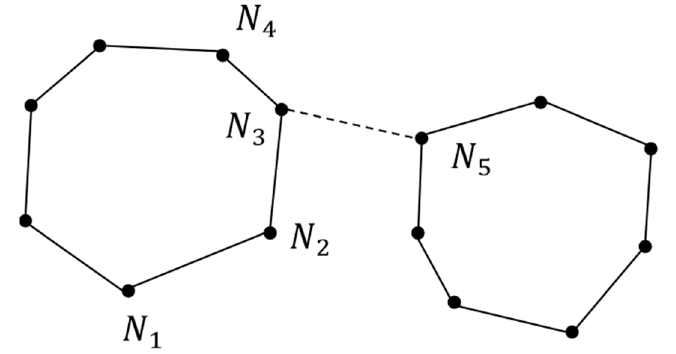
Figure 5. Connection of border